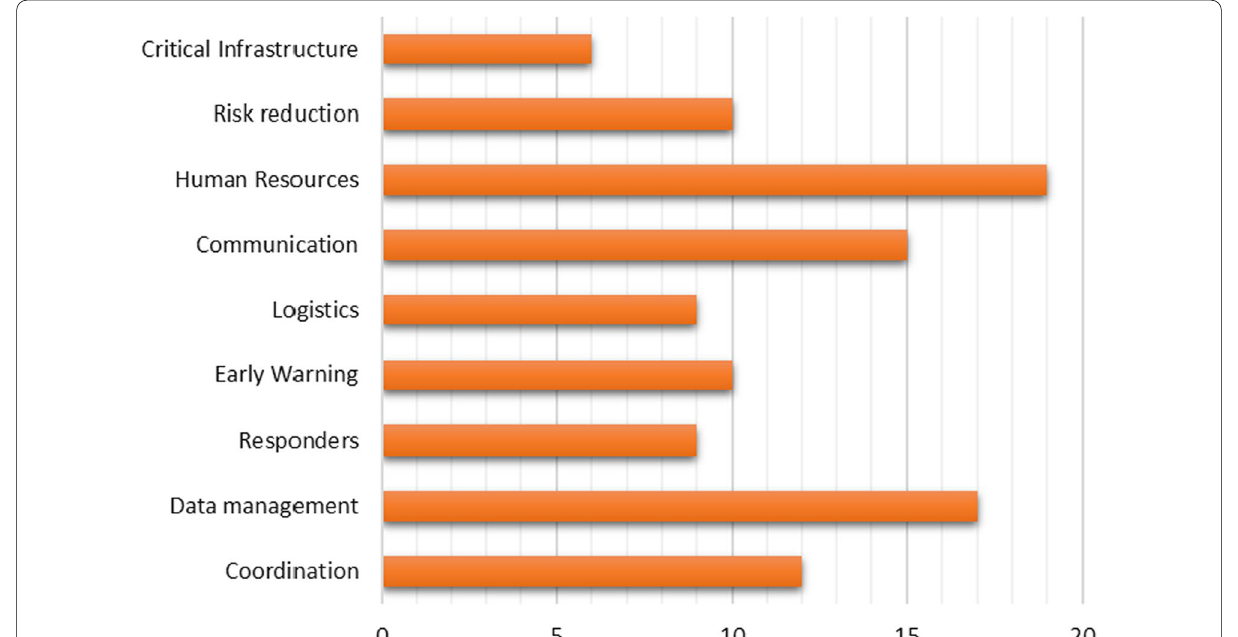
Fig. 3 The disaster management drawbacks as drawn from the study. Source